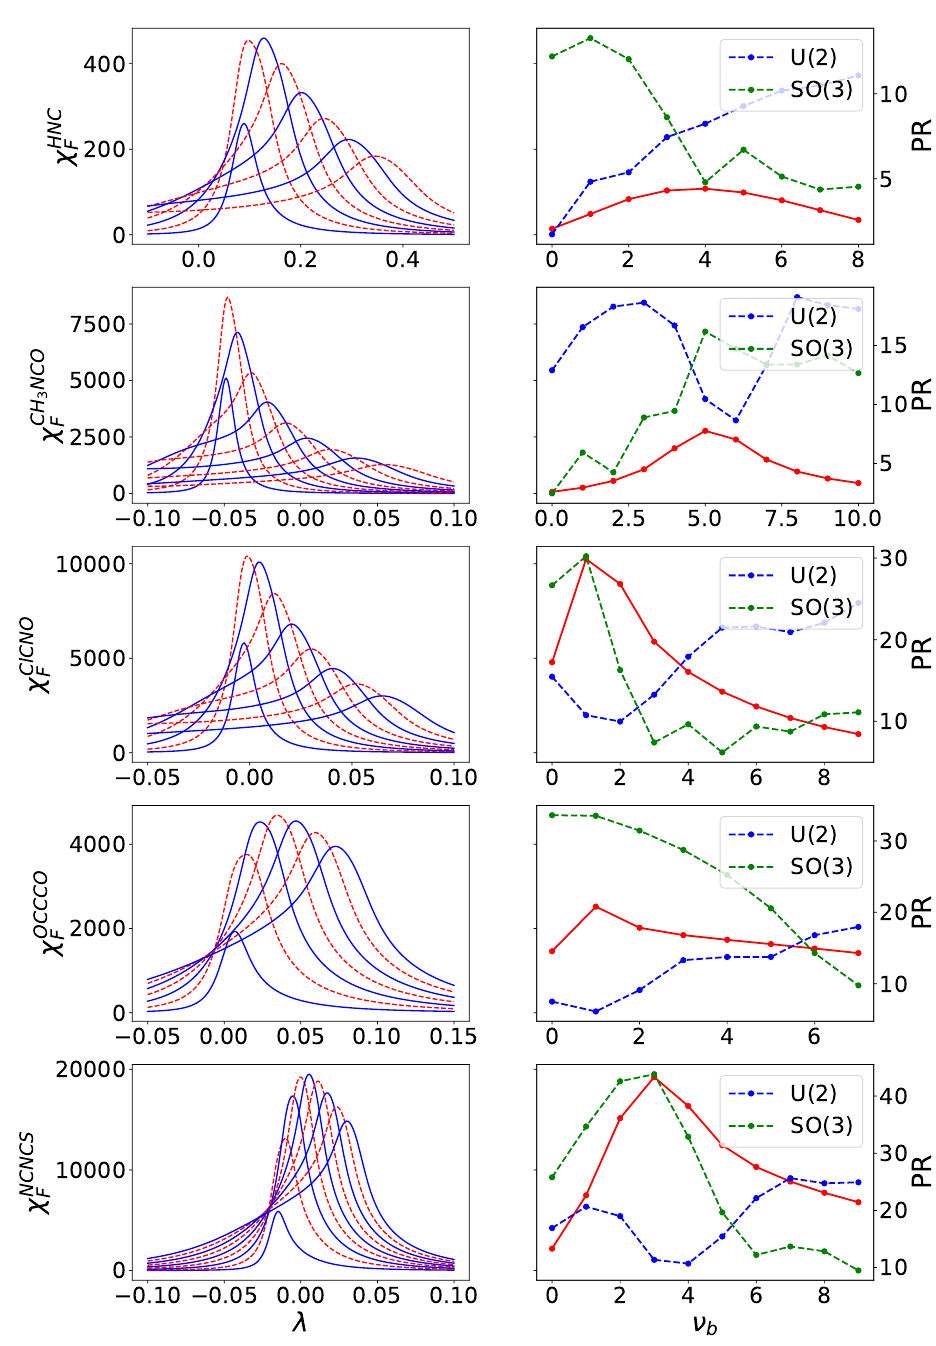
( λ ) , versus the control parameter, F NCO, 37 ClCNO, 3